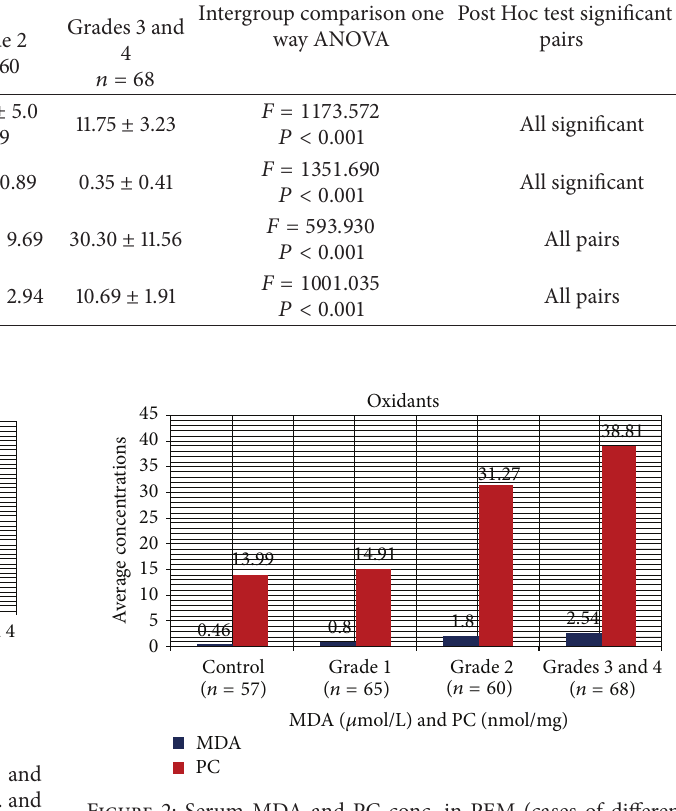
Figure 2: Serum MDA and PC conc. in PEM (cases of different grades, i.e., 1, 2, and 3) and control measured by thiobarbituric acid test [10] and Reznick and Packer [11] method, respectively. Results are expressed as mean ± S.D. 𝑃 < 0.001 by ANOVA